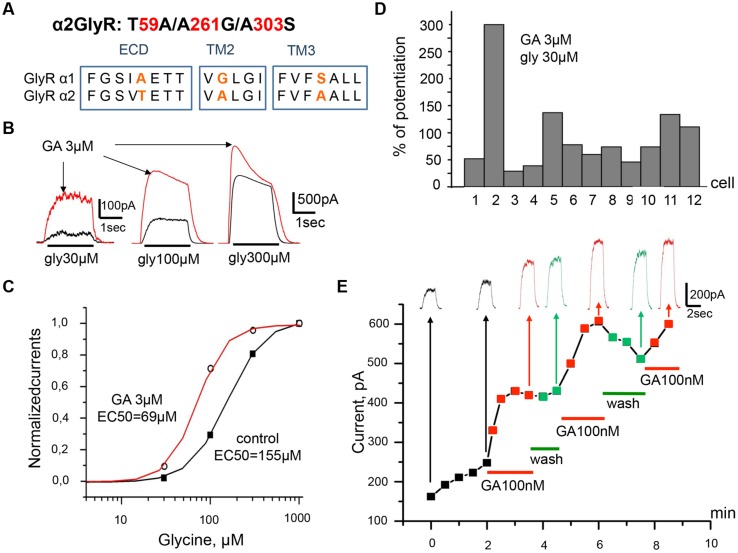
Ginkgolic acid causes potentiation of Igly on cells expressing the mutant α2 (T59A/A261G/A303S) GlyRs.
(A) Primary sequence alignment of α1 and α2 GlyR subunits in the extracellular loop, TM2 and TM3 domains; substituted residues are in red. (B) Superimposed traces of glycine-evoked currents induced by different glycine concentrations (30, 100, 300 μM) in control (black) and after ginkgolic acid (3 μM) application (red). Kgluconate pipette solution, Vh = 0 mV. (C) Ginkgolic acid causes a reduction in EC50 for glycine. Normalized dose–response curves for glycine in control (black squares) and during application of 3 μM of ginkgolic acid (open circles). (D) Percentage of potentiation of glycine (30 μM) evoked currents after ginkgolic acid (3 μM) application for eight individual cells expressing α2 (T59A/A261G/A303S) GlyRs. (E) Example of the time course of the development of the ginkgolic acid effect (3 μM) on the amplitude of the ionic currents mediated by α2 (T59A/A261G/A303S) GlyRs; glycine 30 μM was applied. Kgluconate pipette solution, Vh = 0 mV.